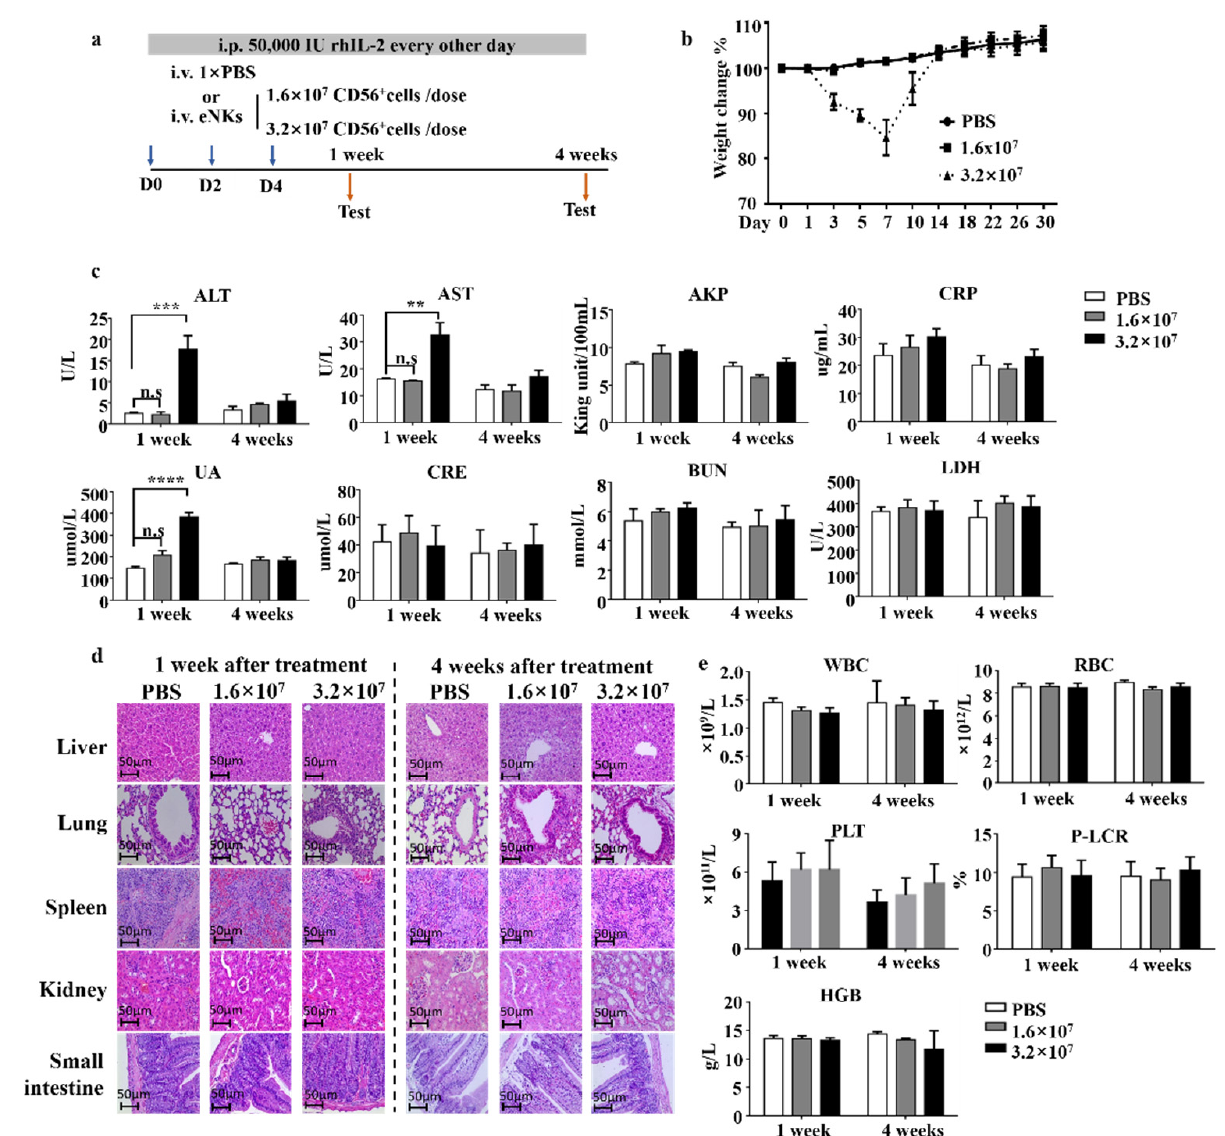
Figure 7. Safety evaluation of eNKs in NCG mice. ( a ) eNKs were adoptively transferred to non-tumor-bearing NCG mice. ( b ) Weight loss was recorded in mice following the injection with two doses of eNKs or PBS, as described in (A). ( n = 5) ( c ) Serum samples were collected after 1 or 4 weeks and then analyzed for standard biochemical parameters: alanine aminotransferase (ALT), aspartate aminotransferase (AST), alkaline phosphatase (AKP), C reactive protein (CRP), uric acid (UA), creatine (CRE), blood urea (BUN), and lactic acid dehydrogenase (LDH). ( d ) Representative images of immunohistochemical staining of GvHD-targeted tissues (including liver, lung, small intestine, spleen, and kidney) at the indicated times. ( e ) Blood test analysis at the indicated times after eNK treatment. White blood cells (WBC); red blood cells (RBC), platelet (PLT), platelet to larger cell ratio (P-LCR), and hemoglobin (HGB). Results are representative of two independent experiments. Data were analyzed by two-tailed paired Student t -test. Data are represented as means ± SD. ** p < 0.01; *** p < 0.001, **** p <